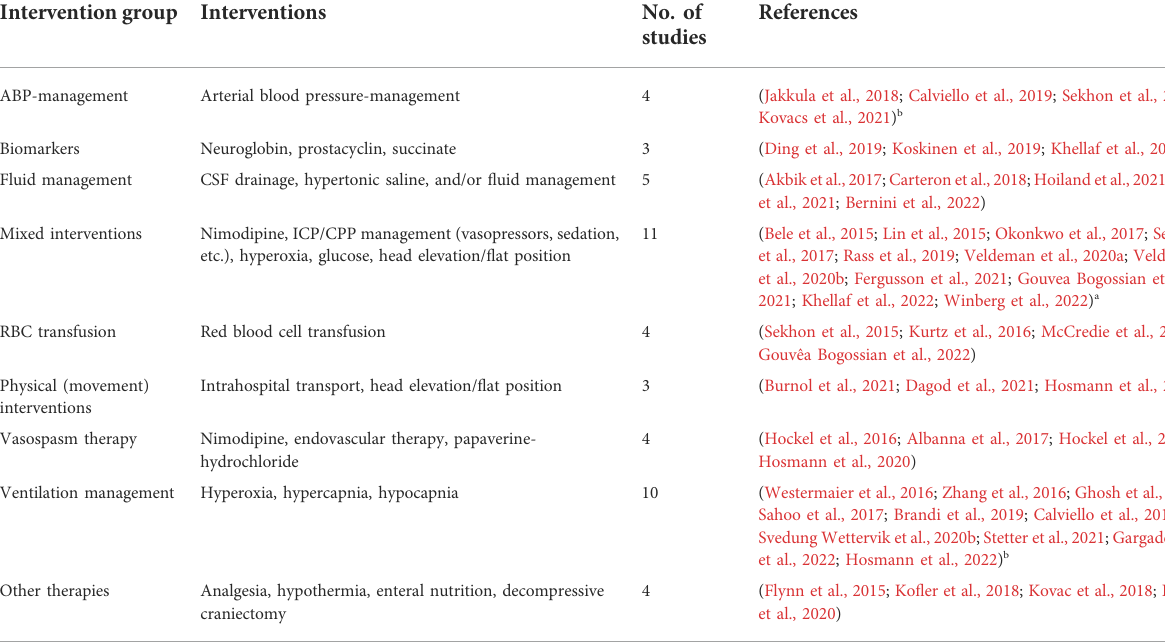
TABLE 4 Systemic-, cerebral- interventions, and interventions guided by cerebral multimodality monitoring in 44 studies. Intervention group